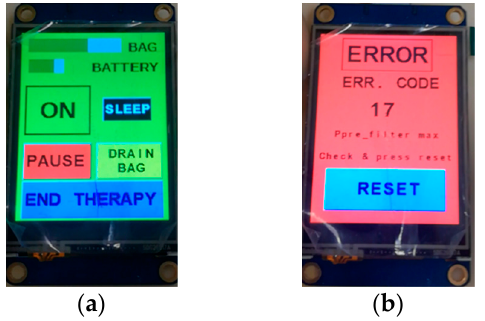
Figure 8. LCD screen during the therapy ( a ), LCD screen after a safety hazard detection ( b ).